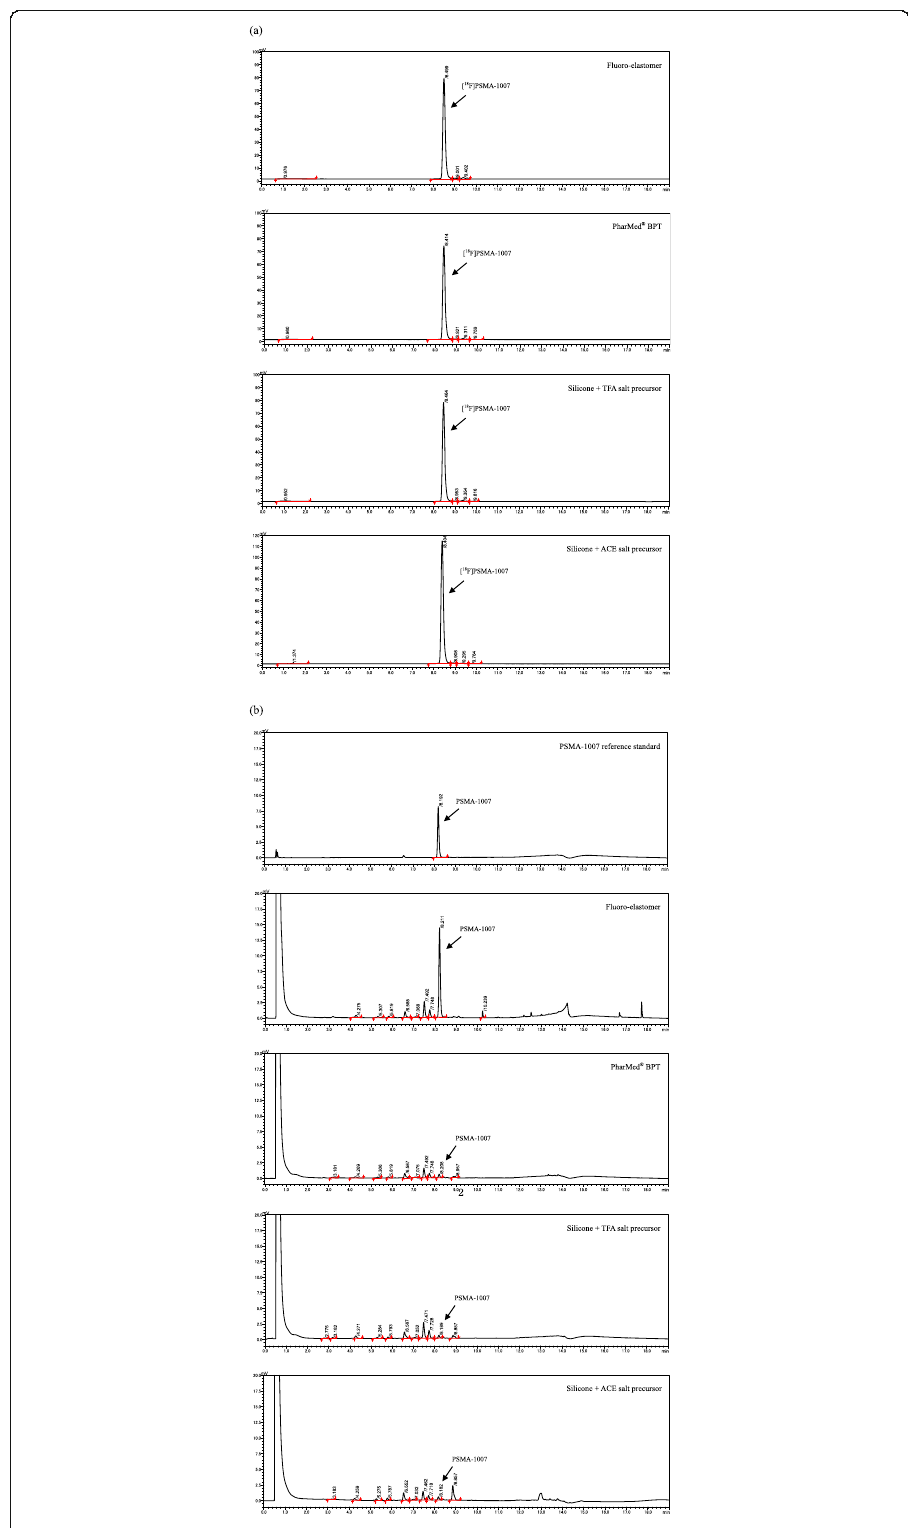
Fig. 6 (See legend on next